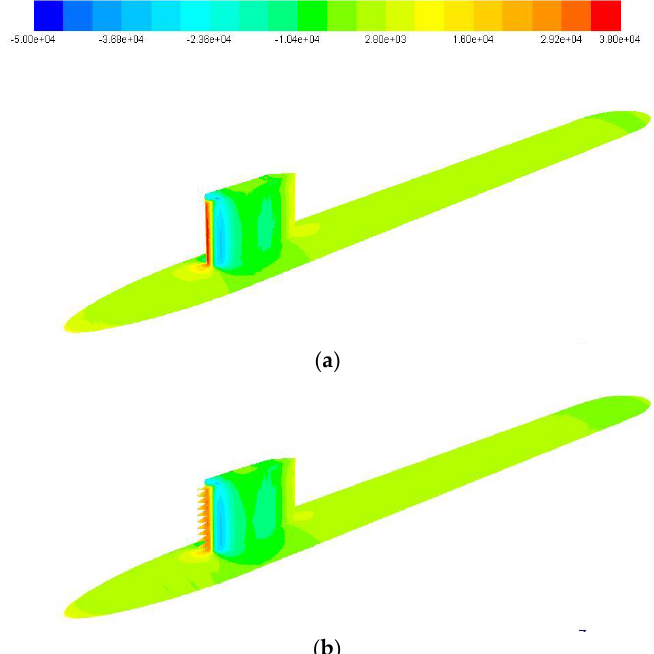
Figure 7. The surface pressure distribution between the two models. ( a ) The original model; ( b ) The model with leading-edge serrations.